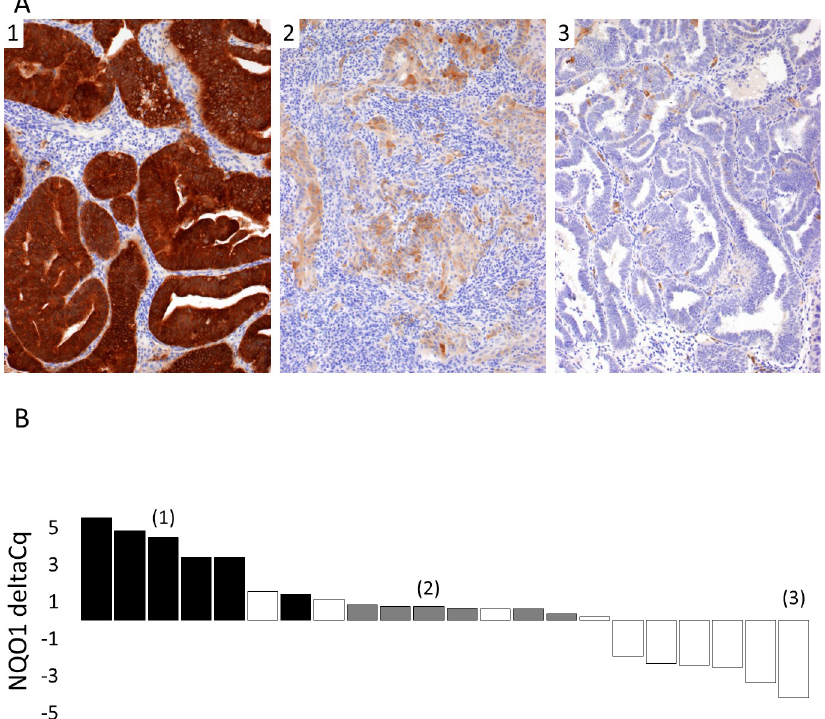
Fig 5. Correlation between NQO1 protein expression and NQO1 mRNA expression. A. Representative examples of NQO1 immunohistochemical assay. Primary NQO1 antibody was used (SIGMA-ALDRICH, HPA007308), revealed with Leica Bond Polymer Refine Detection System Kit. 10X objective. Sample (1): NQO1 high case. Sample (2): NQO1 intermediate case. Sample (3): NQO1 low case. B. NQO1 mRNA levels and NQO1 immunohistochemical assay results. NQO1 expression measured by quantitative RT-PCR is shown as barplot. y- axis display delta Cq expression. Black bars highlight samples with high NQO1 protein expression. Grey bars highlight samples with intermediate NQO1 protein expression. White bars highlight samples with low NQO1 protein expression. (1), (2), and (3) refer to samples for which NQO1 immunohistochemical assay results are provided on Fig 5A.